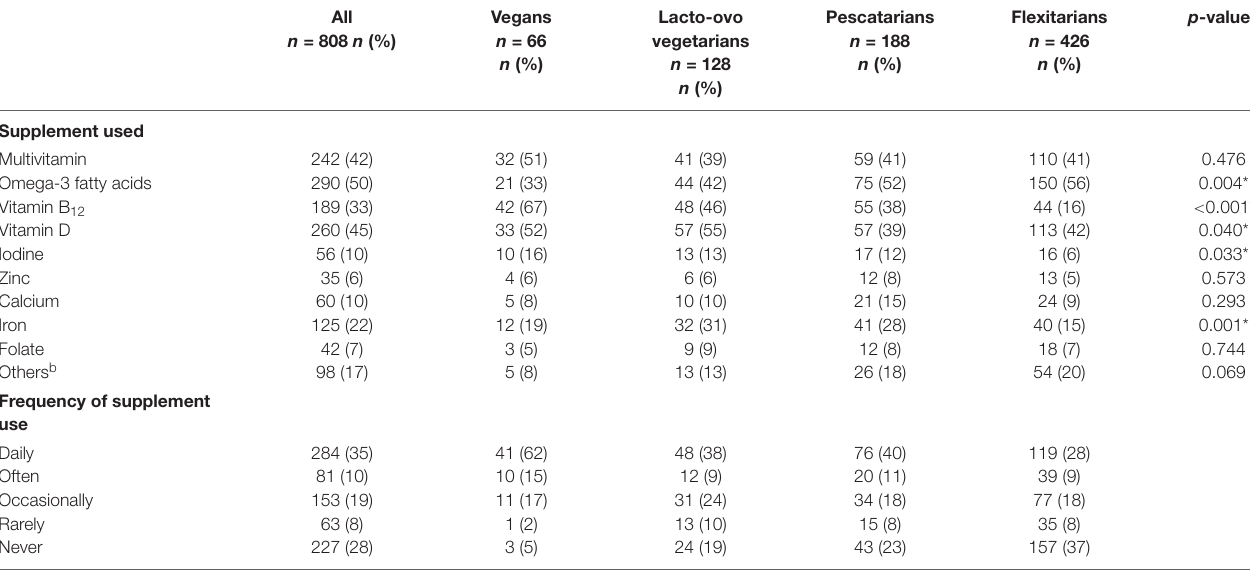
TABLE 3 | Supplement use among Norwegian adults with vegan, lacto-ovo vegetarian, pescatarian, and flexitarian diets ( n =